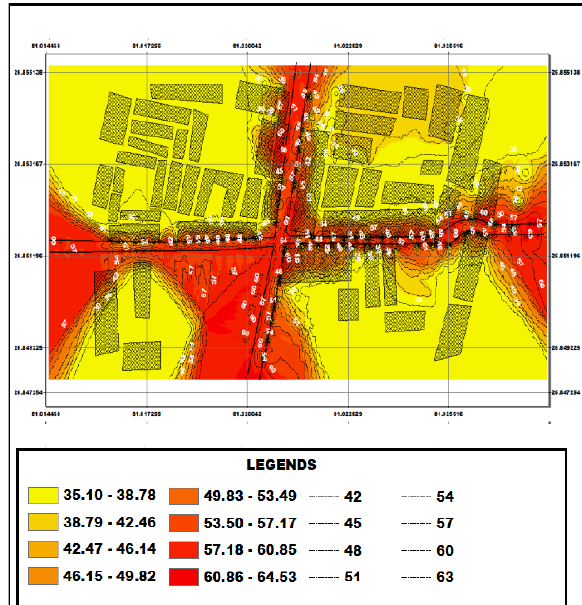
Figure 8. Noise level map of Haniman at evening time using NoiseCapture app scaled with standard SPL.